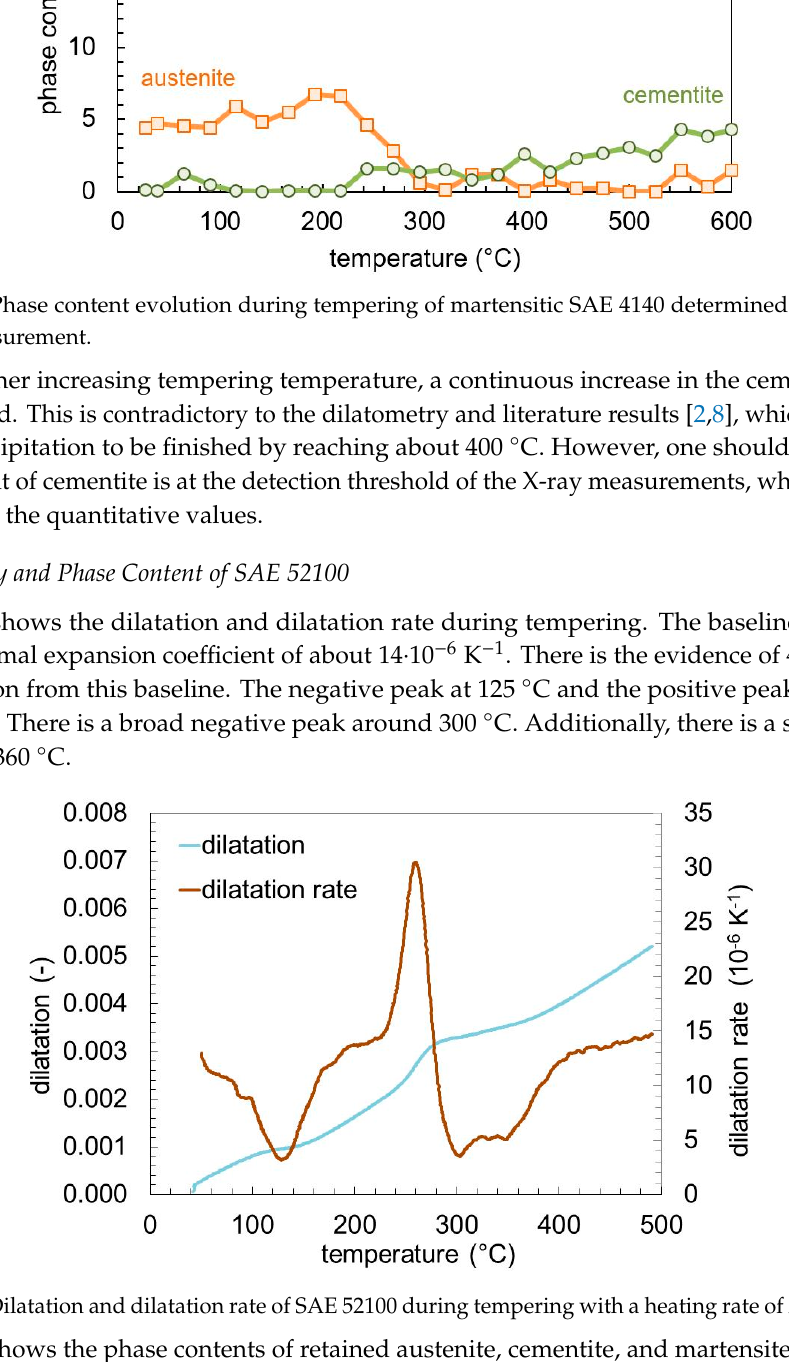
Figure 7. Dilatation and dilatation rate of SAE 52100 during tempering with a heating rate of 2 K min − 1 .